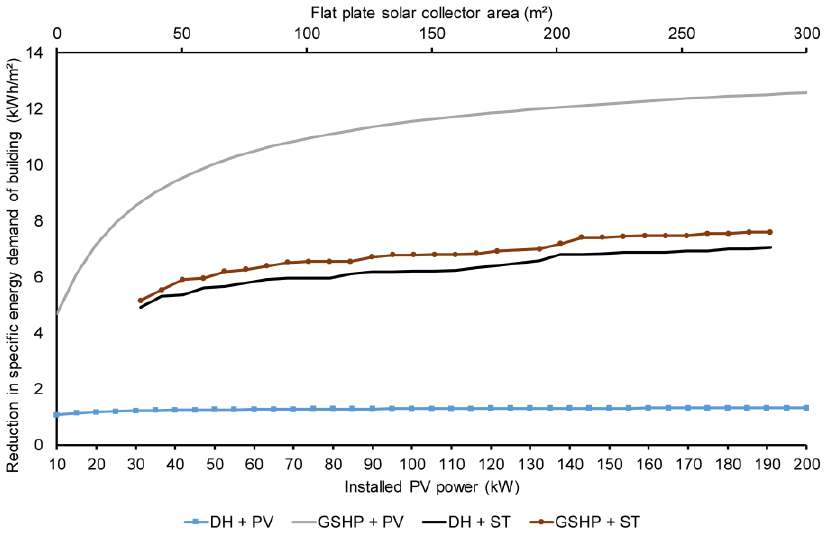
Figure 8. Reduction in specific energy demand for all system combinations as a function of installed PV power or flat-plate collector area.